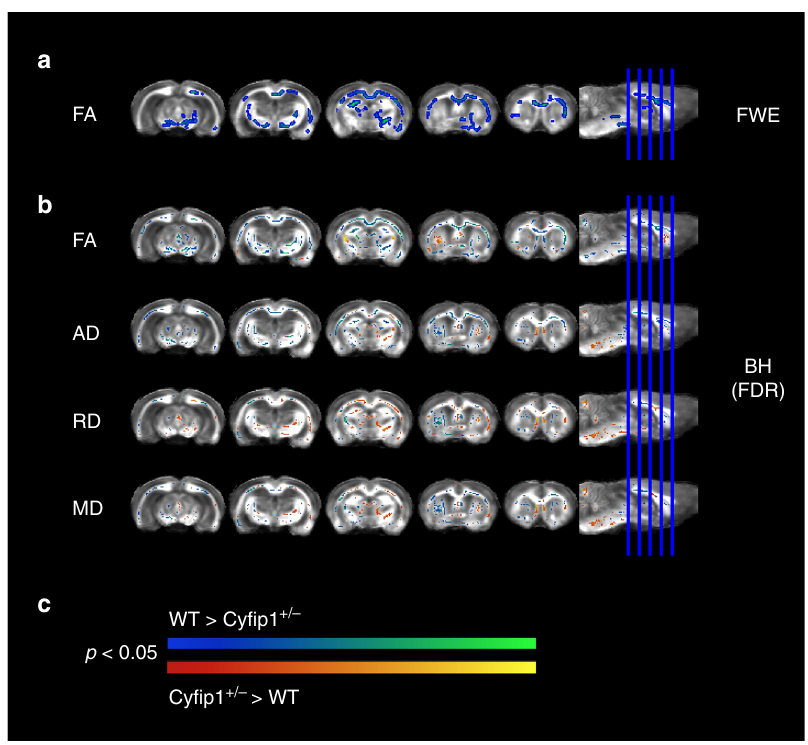
Fig. 1 Cy fi p1 haploinsuf fi ciency disrupts white matter microstructure. White matter changes comparing WT ( n = 12) and Cy fi p1 + / − ( n = 12) rats. Data shows signi fi cant group differences using two-tailed unpaired t-tests based on Threshold-Free Cluster Enhancement (TFCE) algorithm after a family-wise error (FWE) rate correction for fractional anisotropy (FA), and b false discovery rate (FDR) correction based on the Benjamini – Hochberg procedure for FA, axial diffusivity (AD), radial diffusivity (RD) and mean diffusivity (MD). All the parametric maps were generated at a signi fi cance level of p < 0.05. c Scale bars indicating the direction of the changes in both a , b , where relative decreases in Cy fi p1 + / − rats are represented by a gradient of blue (less signi fi cant) to green (more signi fi cant), and relative increases in Cy fi p1 + / − are represented by a gradient of red (less signi fi cant) to yellow (more signi fi cant) Table 1 Quanti fi cation of DTI changes in regions where signi fi cant differences in FA were seen in TBSS analysis after FWE